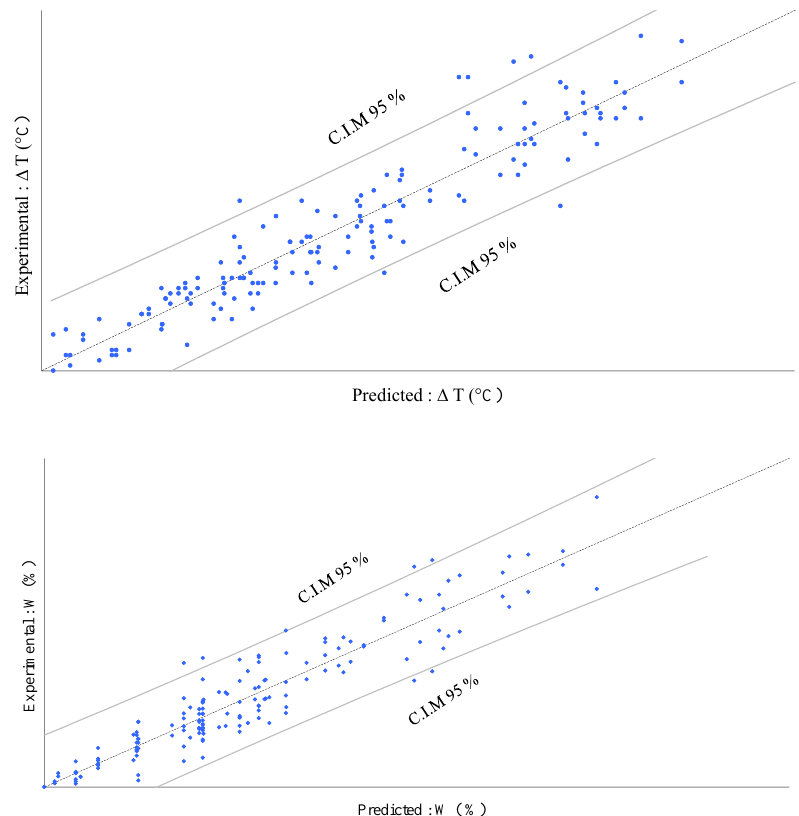
Figure 5. Model predictions vs. experimental results for T and W with two confidence intervals on mean (C.I.M) of the prediction at 95%.